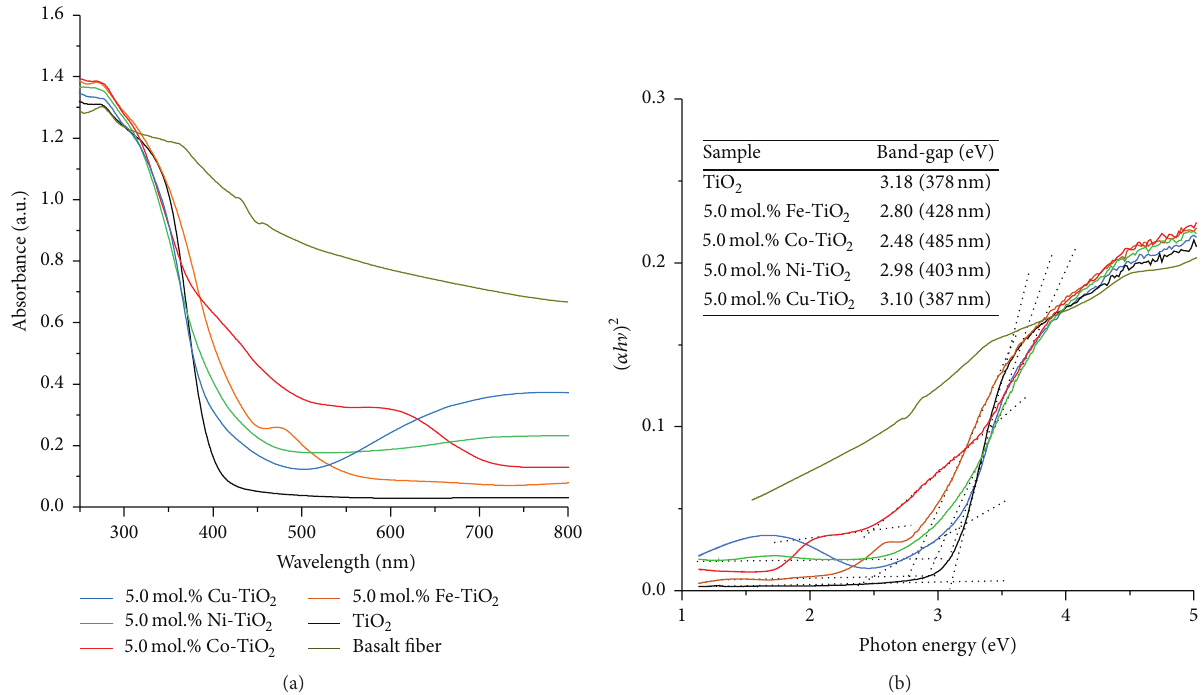
Figure 3: Diffuse reflectance-UV-visible absorption spectra (a) and their Tauc’s plots (b) of the prepared 5.0 mol.% M-TiO 2